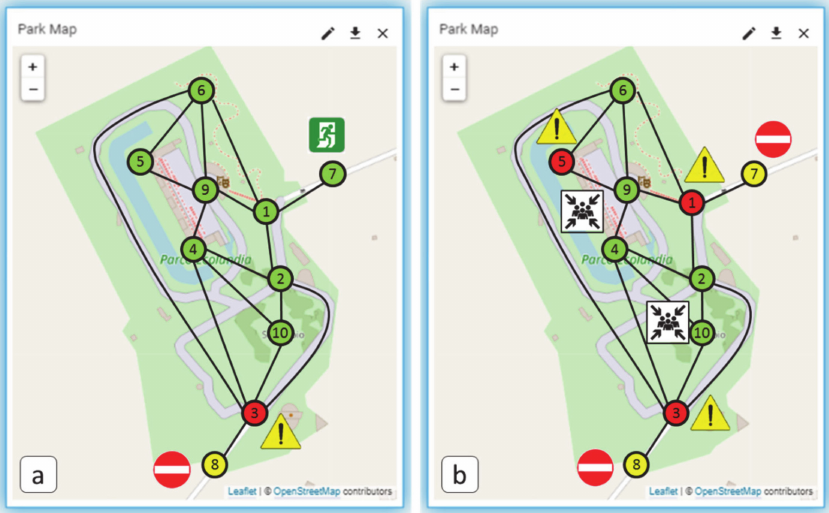
Figure 8. Two examples of emergency plans in case of an environmental / structural alarm active at ( a ) node 3, and ( b ) nodes 1, 3, and